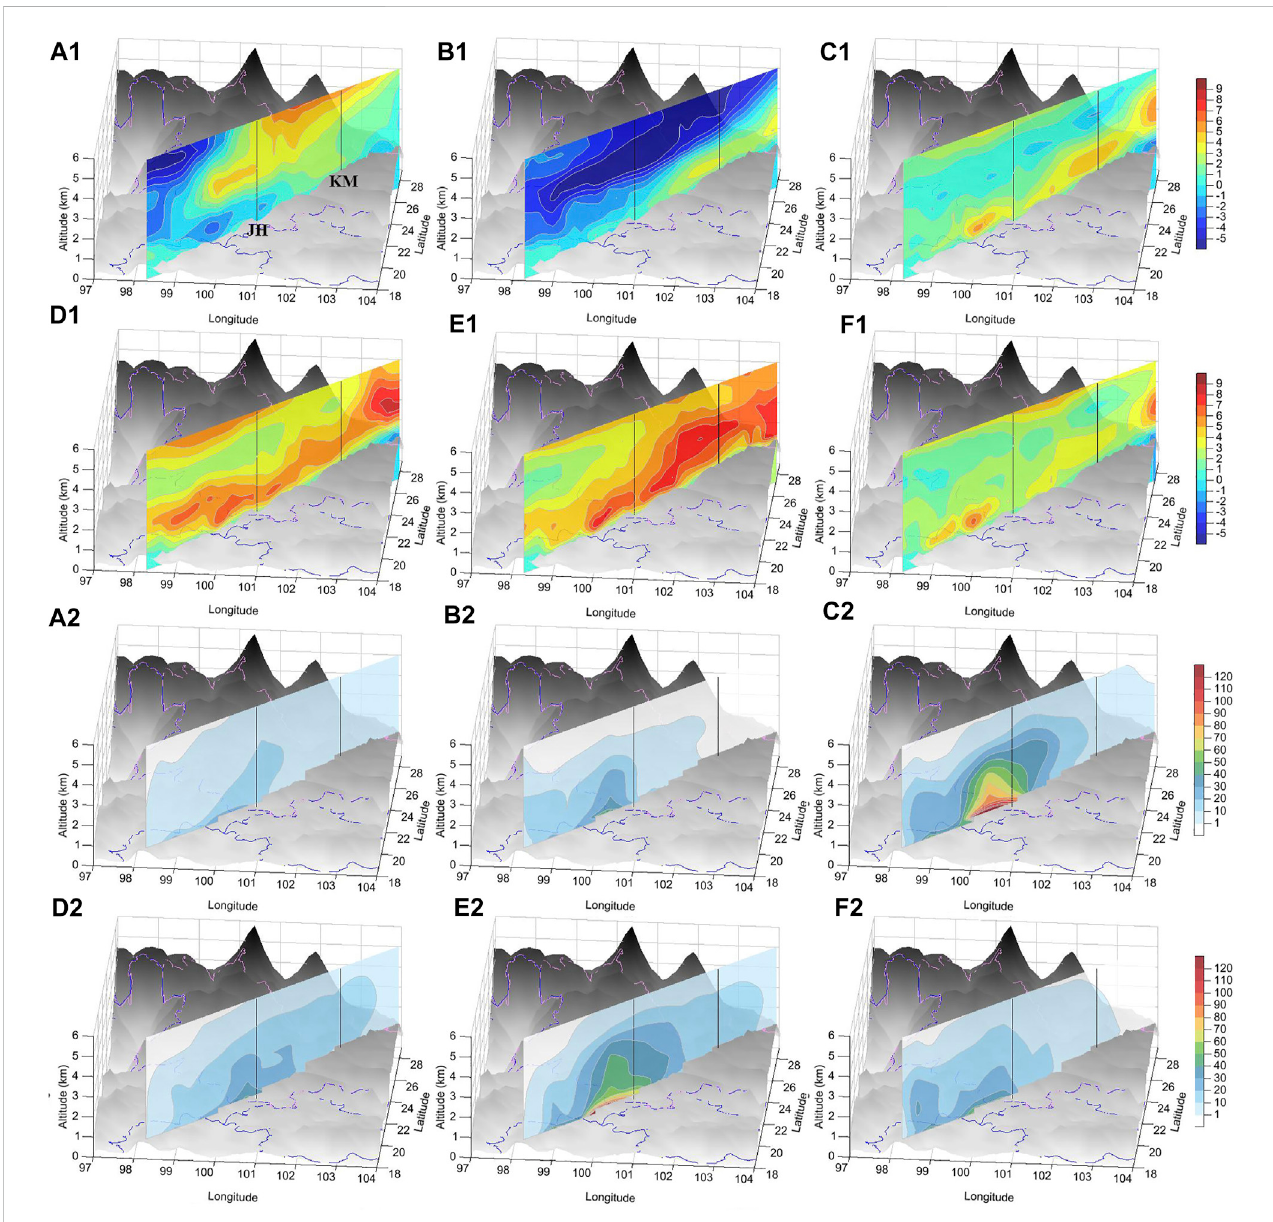
FIGURE 9 The vertical pro fi les ofdaily mean (A1 – F1) Meridional wind(ms − 1 )and (A2 – F2) themodelsimulated PM 2.5 concentrations ( μ gm − 3 )producedbybiomass burninginSoutheastAsiaacrossJHandKMfrom28Marchto2April2019 (A – F) .TheblacklinesdenotethelocationofKunming(KM,Northeast)andJinghong (JH,